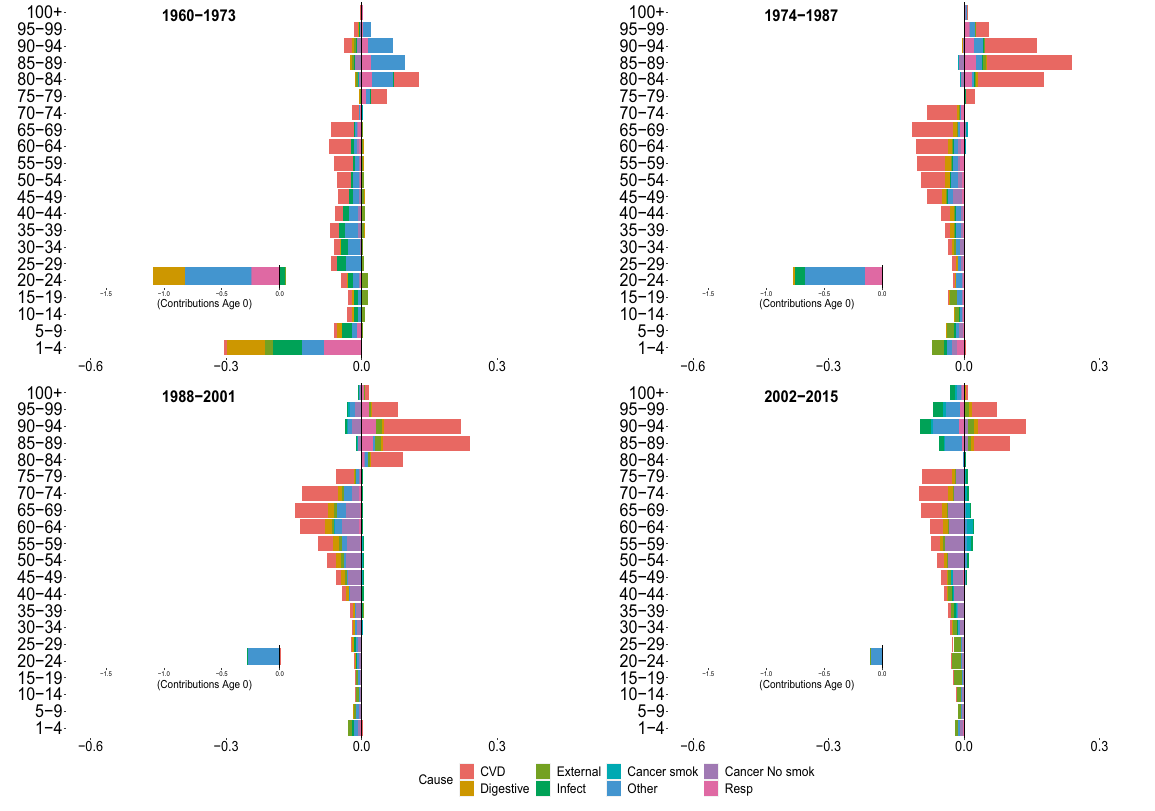
Figure 4. Age and cause contributions to changes in lifespan inequality for Italian